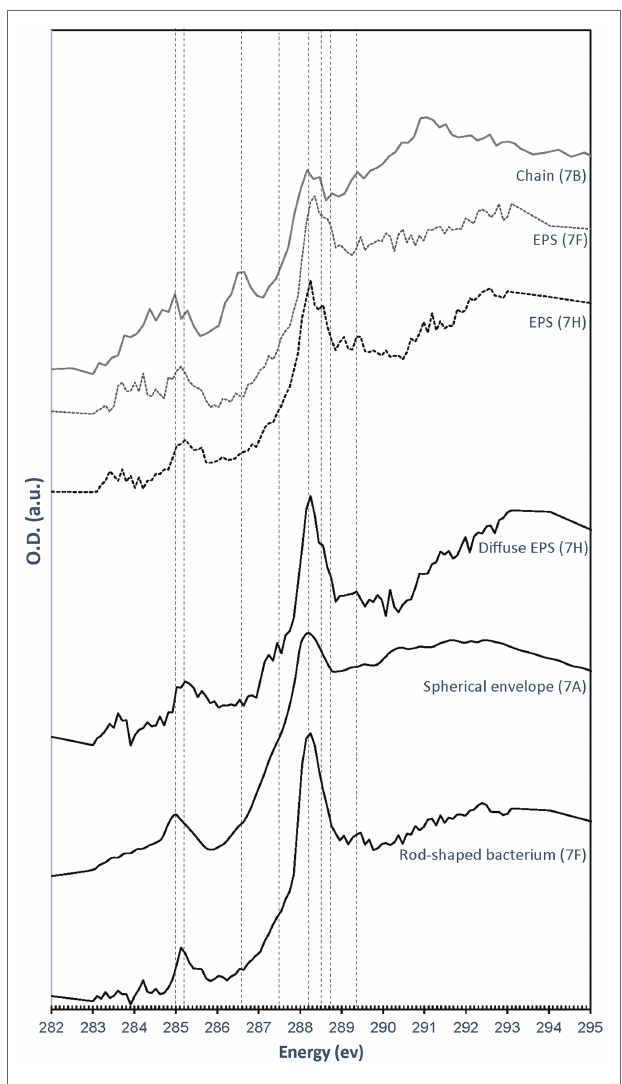
FIGURE 8 | C K-edge XANES spectra obtained on the particles and cells shown in Figure 7 . Dashed lines correspond to absorption energies for different organic functional groups: 285 eV (1 C C s p® * = transitions in aromatics or unsaturated carbon), 285.2 eV (1 C C s p® * = transitions in aromatics), 286.6 eV (1 s →π * transitions in ketones, pyridines, and